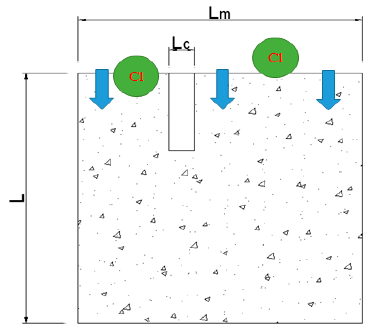
Figure 4. Anisotropic (1-D) cracks in concrete.